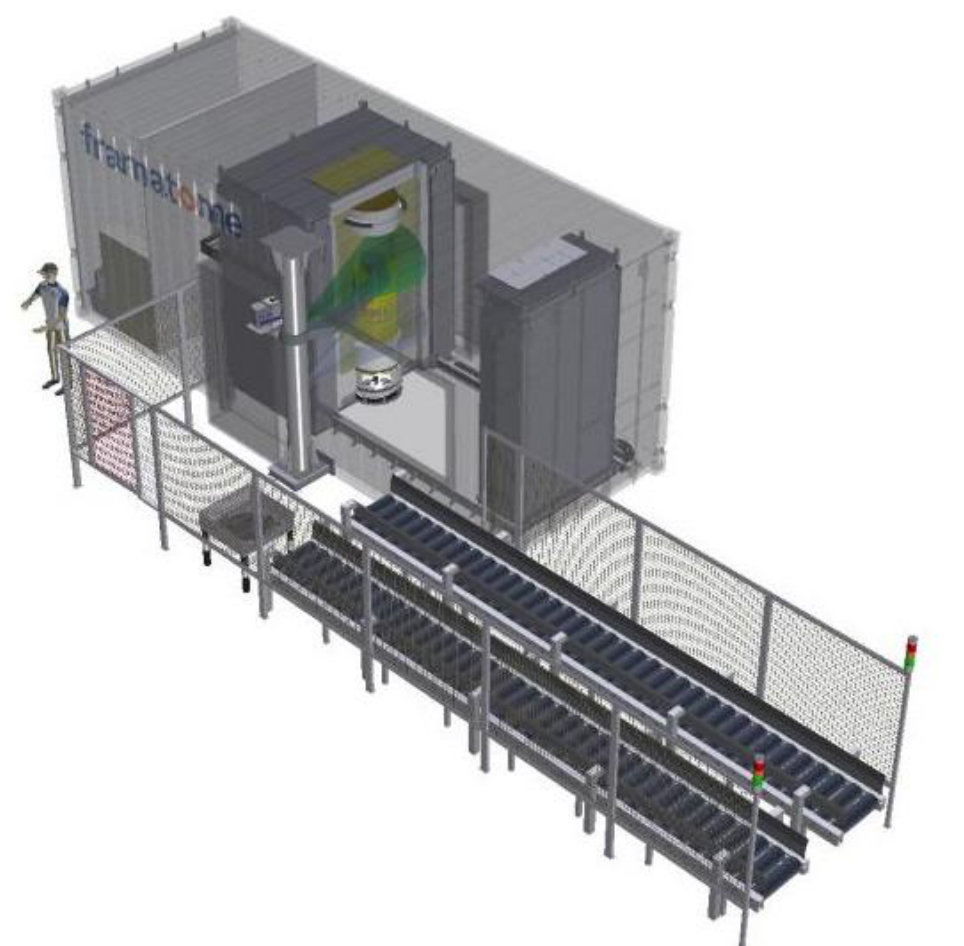
Figure 5: Design of the QUANTOM ® measurement device integrated in a 25´-Container as well as the automatic drum loading